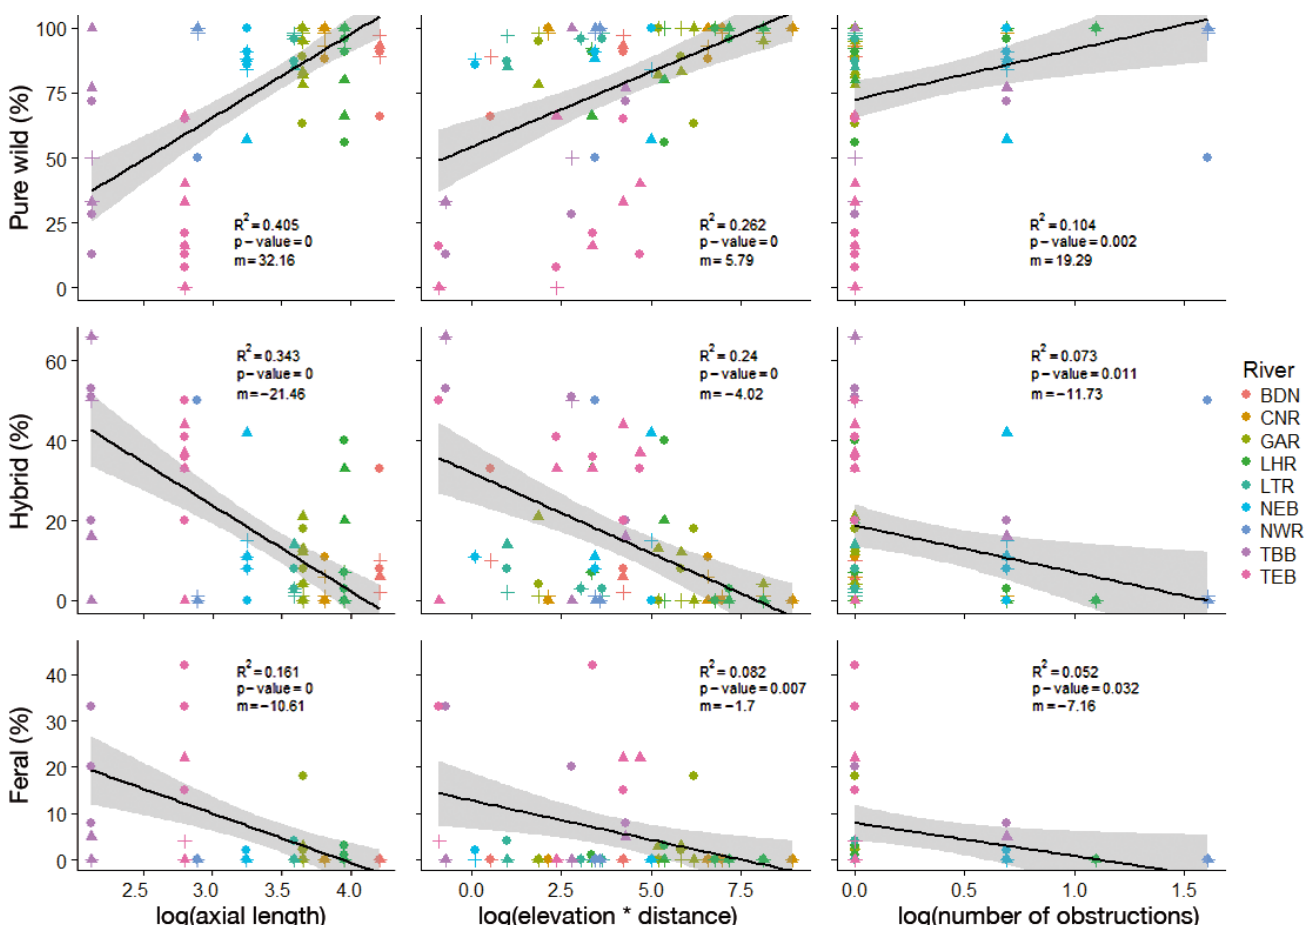
Fig. 5. Linear regressions of Atlantic salmon group composition against log-transformed variables: axial length, minimum migration effort (as estimated by the product of elevation and upstream migration distance), and the number of obstructions along a migratory route to a given site. Each point represents an age class per sampling site within a river. Crosses: young-of- year; circles: 1+ parr ; triangles: 2+ parr. Sampling sites are indicated by colour. Shaded grey areas indicate standard error of the regression, with R 2 , p-values, and slope (m) shown for each regression analysis. River abbreviations are as in Table 1, corresponding to colours in Fig.